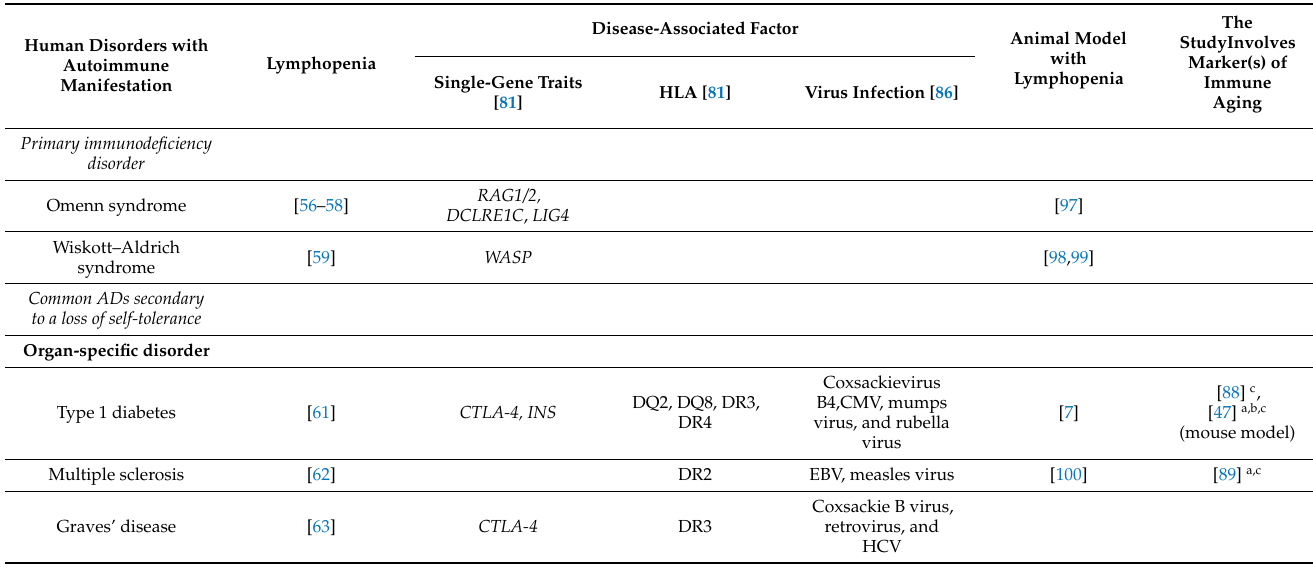
Table 1. Lymphopenia-associated disorders in